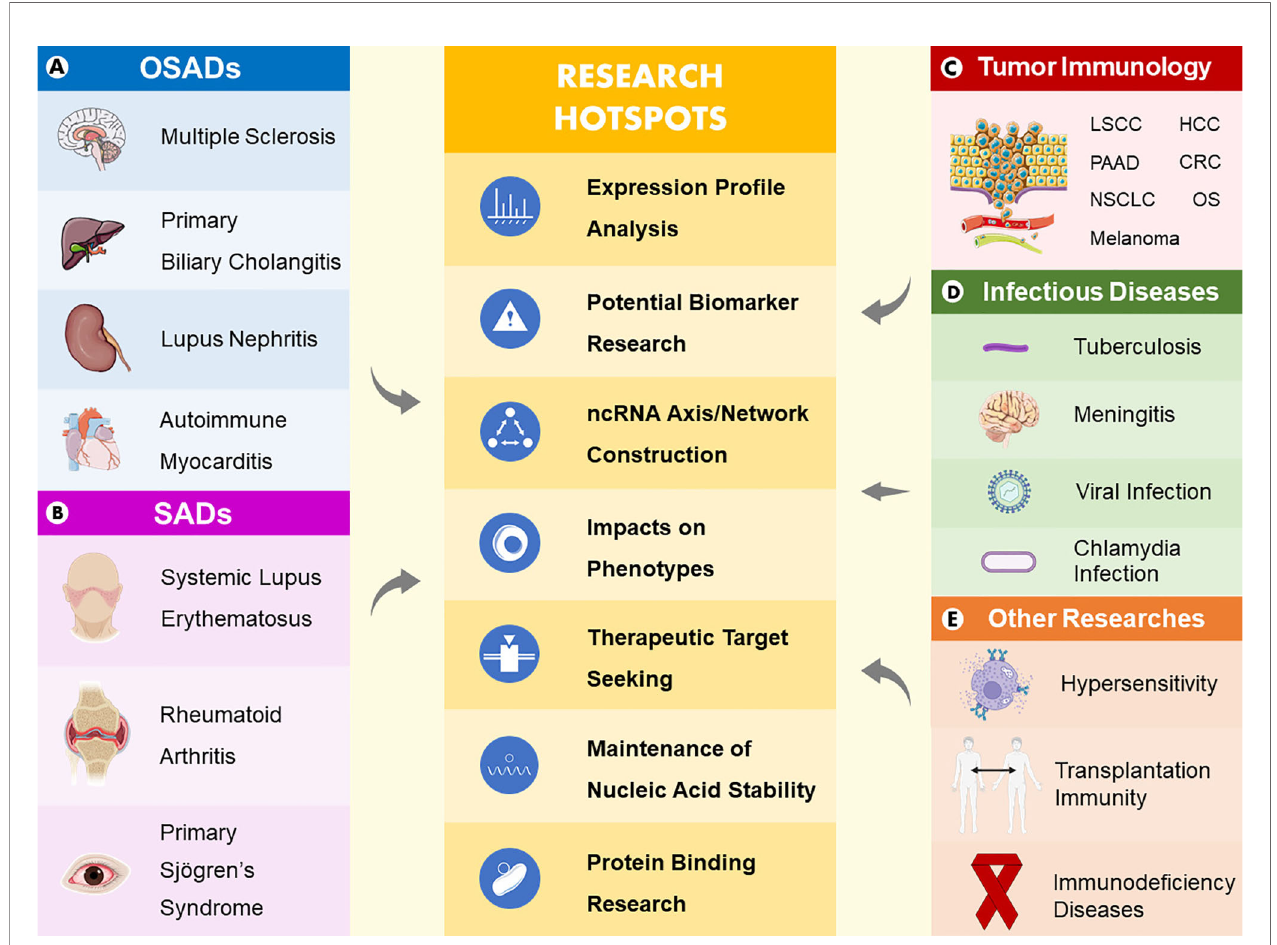
FIGURE 2 | Main areas and research hotspots of the roles of circRNAs in immune-related diseases. Five main areas consist of organ-speci fi c autoimmune diseases (A) , systemic autoimmune diseases (B) , tumor immunology (C) , infectious diseases (D) , and other studies (E) . In summary, research hotspots of the roles of circRNAs in immune-related diseases include expression pro fi le analyses, potential biomarker research, ncRNA axis/network construction, impacts on phenotypes, therapeutic target seeking, maintenance of nucleic acid stability and protein binding